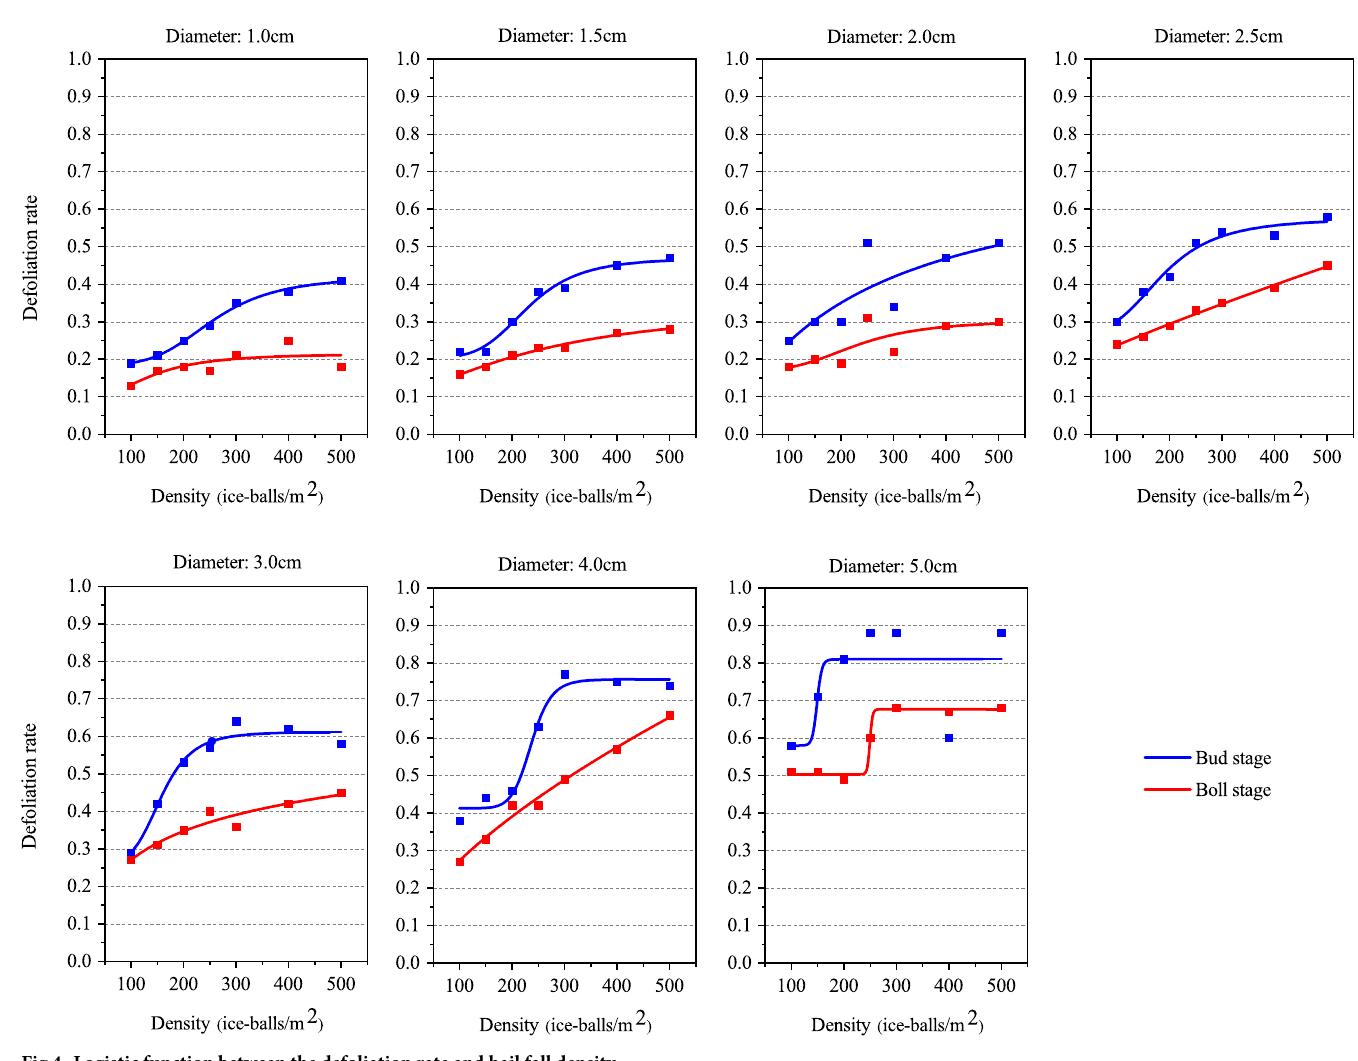
Fig 4. Logistic function between the defoliation rate and hail fall density.